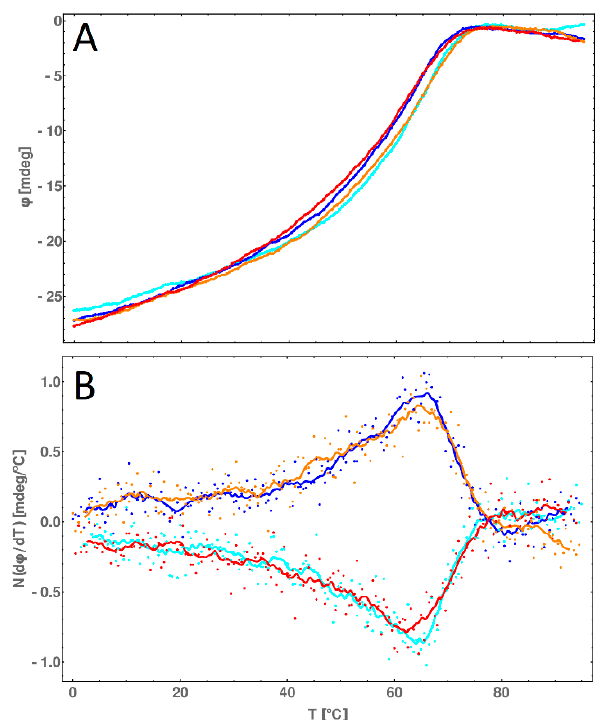
Molecules 2020 , 25 , x 13 of 18 Different measurements (for both heating and cooling) were conducted at a 1 °C/min heating/cooling rate from 0 to 90 °C or 90 to 0 °C and normalized against TBA buffer.